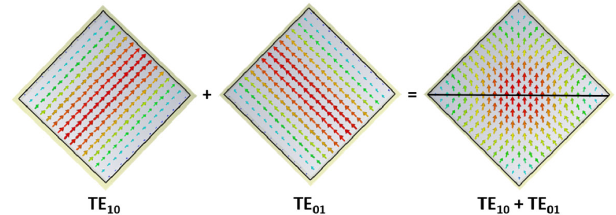
FIG. 7. Electric field of the first two degenerate modes inside a square waveguide and sum (right) of the first two modes propagating when a slab is placed in the